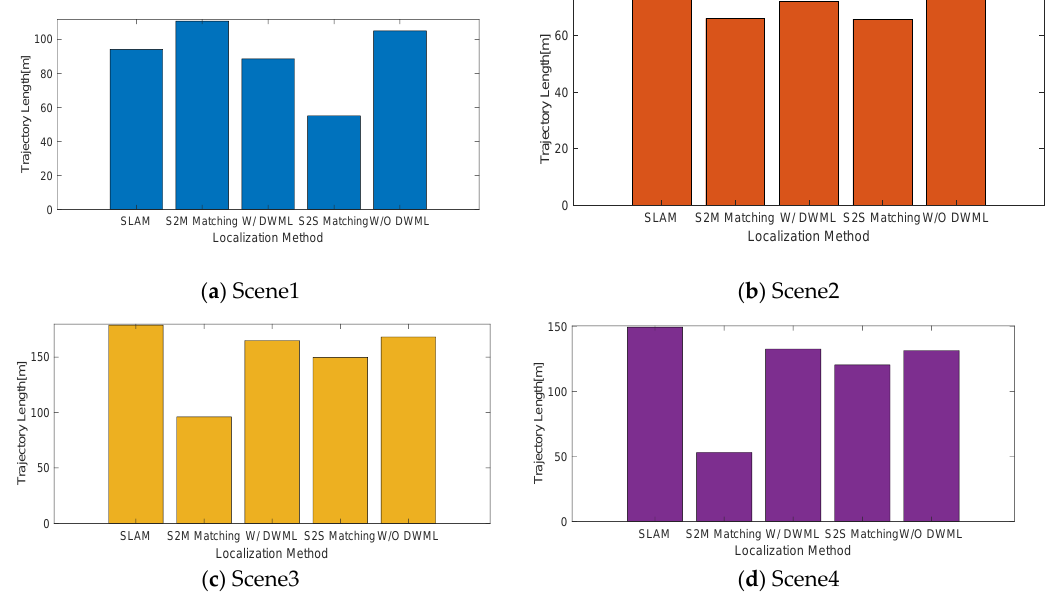
Figure 17. Walking distance of the four underground roadway scenes.